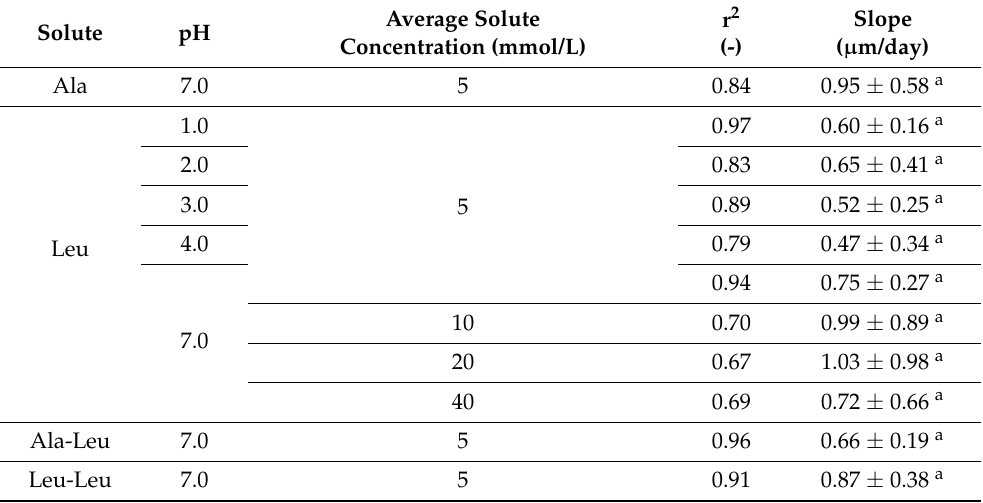
Table 1. Average rate of change (and 95% confidence interval) and determination coefficient (r 2 ) as determined by linear regression analysis of the volume-weighted average droplet size during 16 days of storage at 37 ◦ C (expressed in µ m/day) of double emulsions containing HOSO. Solute